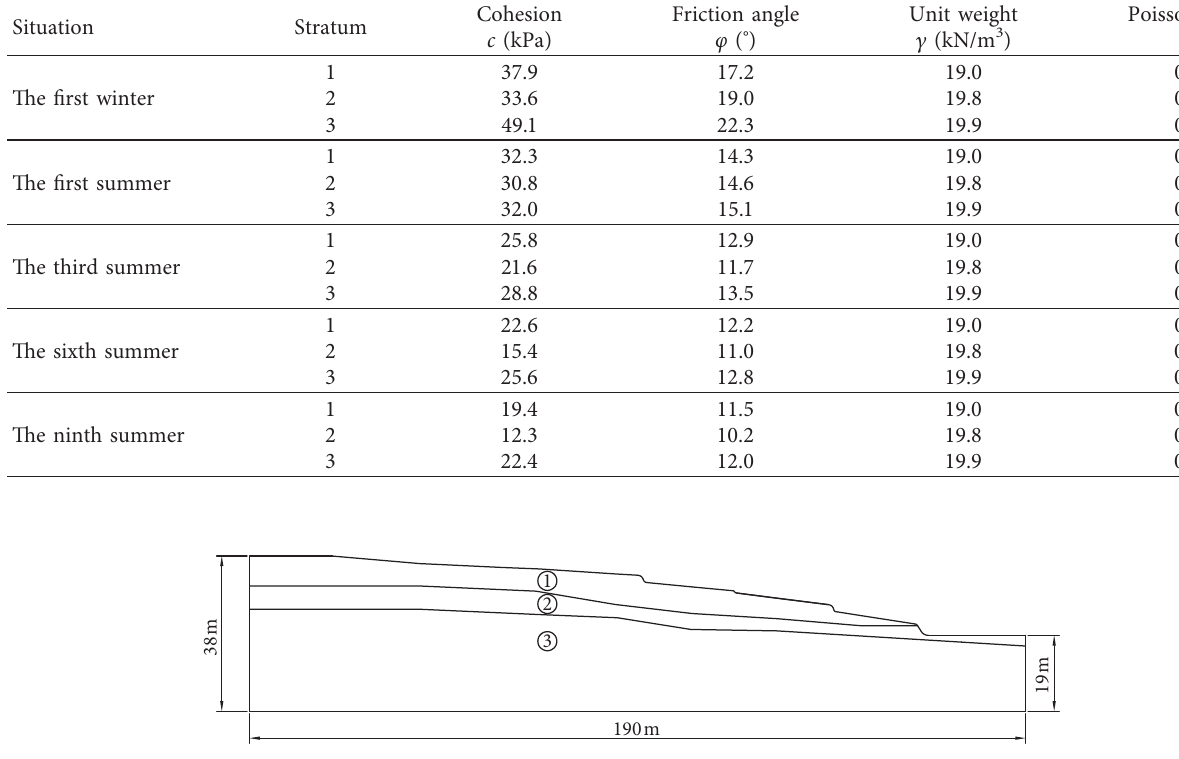
Table 3: Soil parameters for the slope stability analysis.